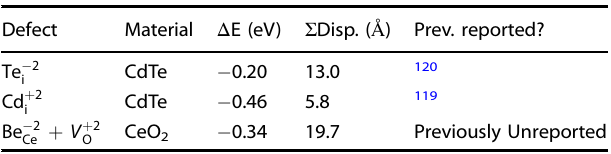
Table 4. Electrostatically-driven reconstructions. Energy difference and summed atomic displacements ( Σ Disp.) between the ground state identi fi ed by our method and the metastable con fi guration a found when relaxing the ideal, undistorted defect structure (i.e., Δ E = E − E ground metastable ).